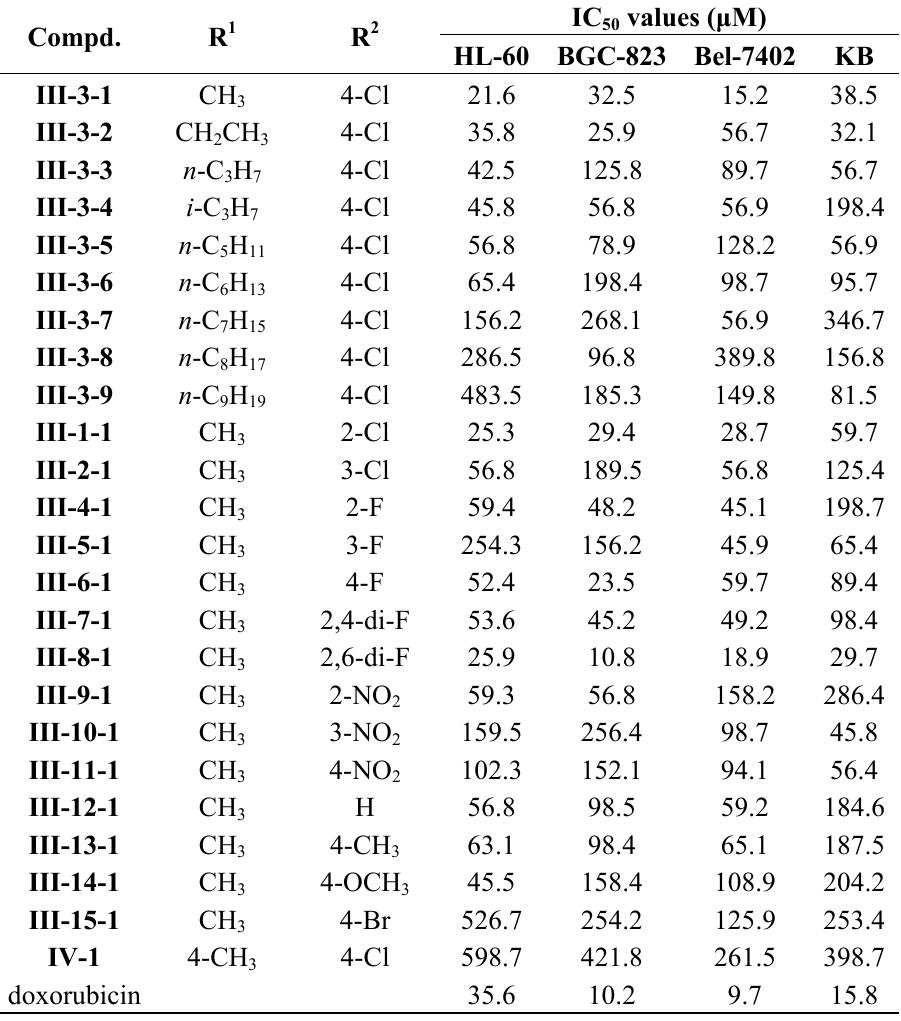
Table 6. Anti-tumor activity of title compounds III